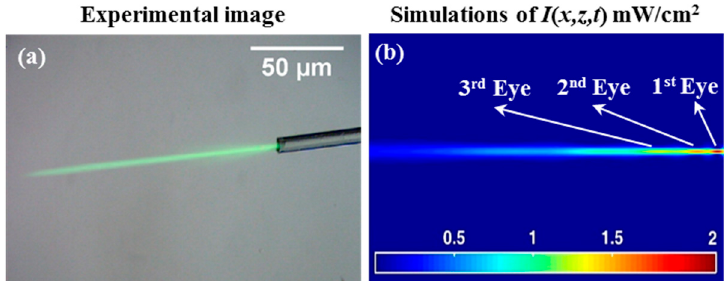
Figure 4. Light incident (from right to left) from a single mode optical fiber, t exp = 1600 s of λ = 532 nm and P 0 = 0.1 mW: ( a ) experimental image results and ( b ) the corresponding numerical intensity predictions, I ( x,z,t ) mW/cm 2 .